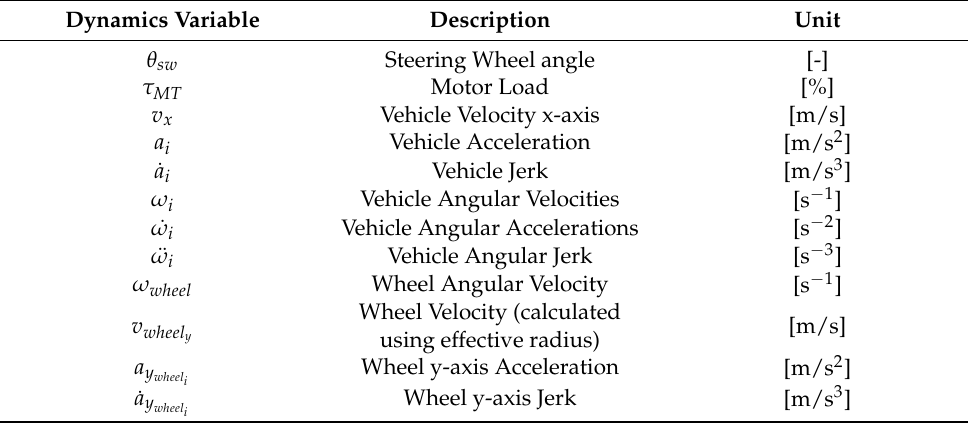
Table 2. List of potential network input